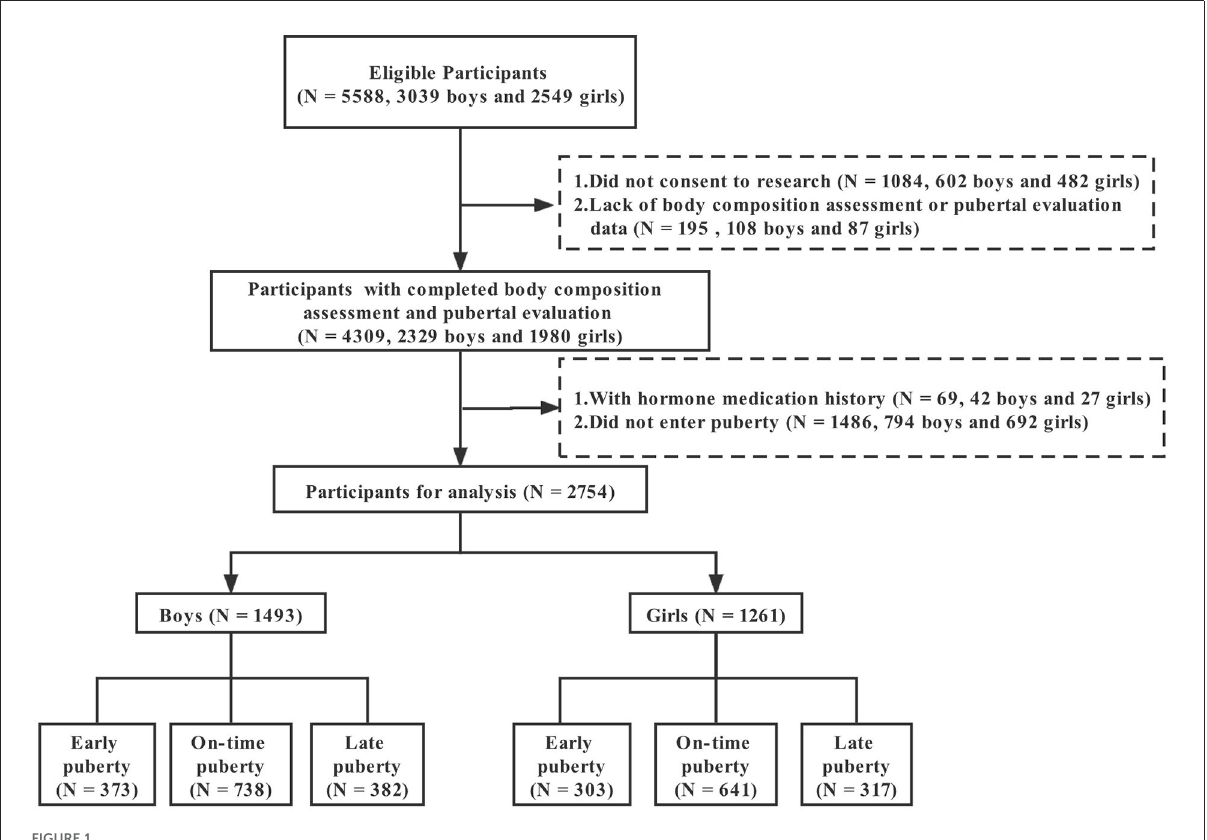
FIGURE1 Flow diagram of study recruitment and